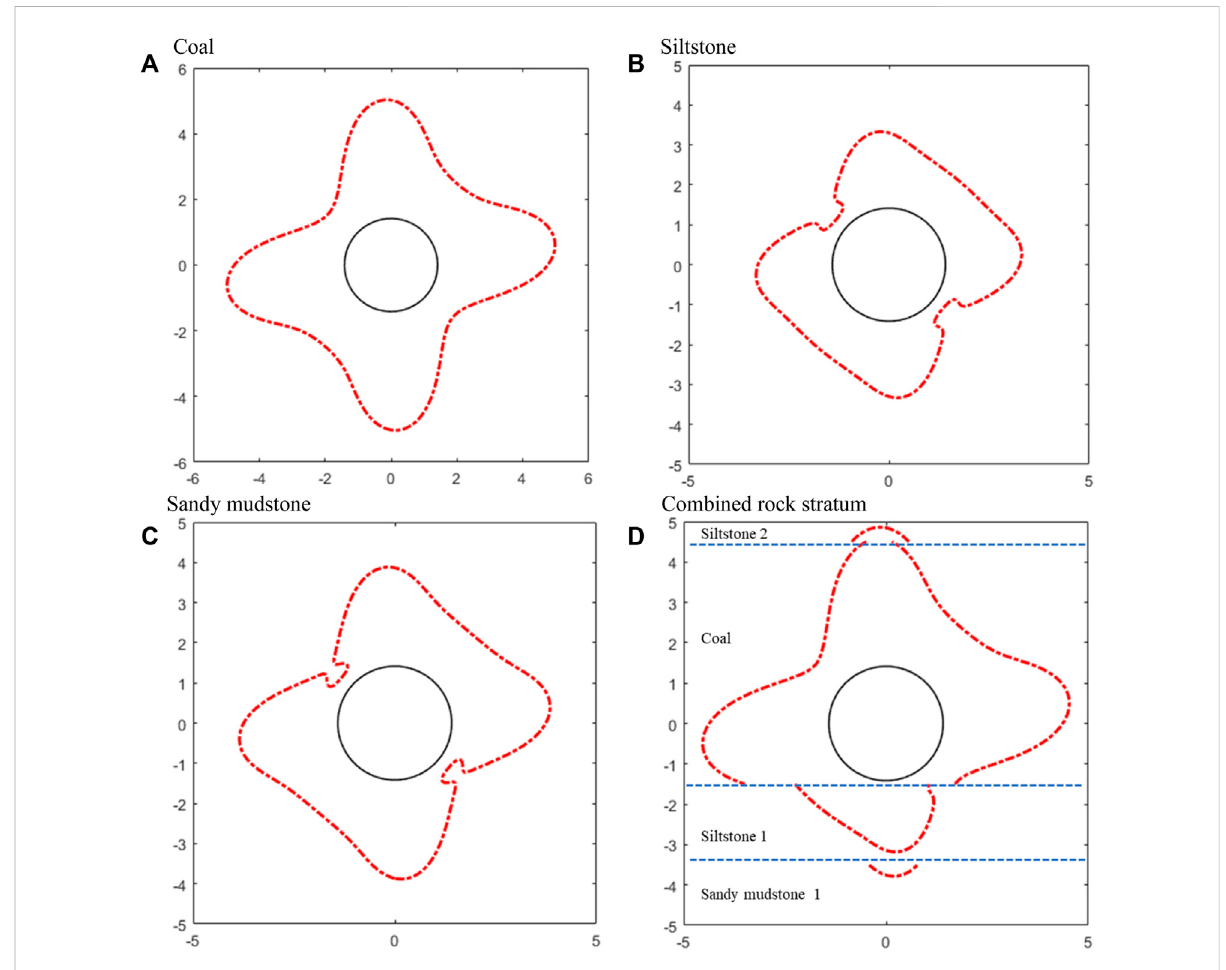
FIGURE 10 In fl uence of different rock structures on the plastic zone of the surrounding